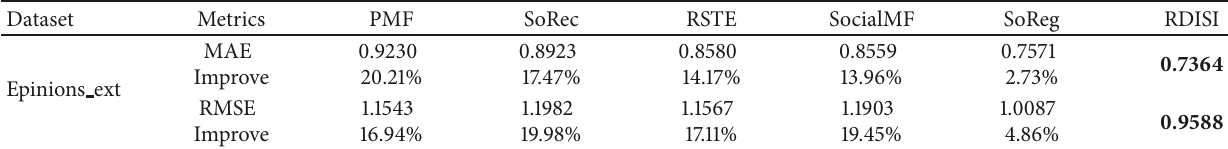
Table 6: Performance comparisons (dimensionality =20).